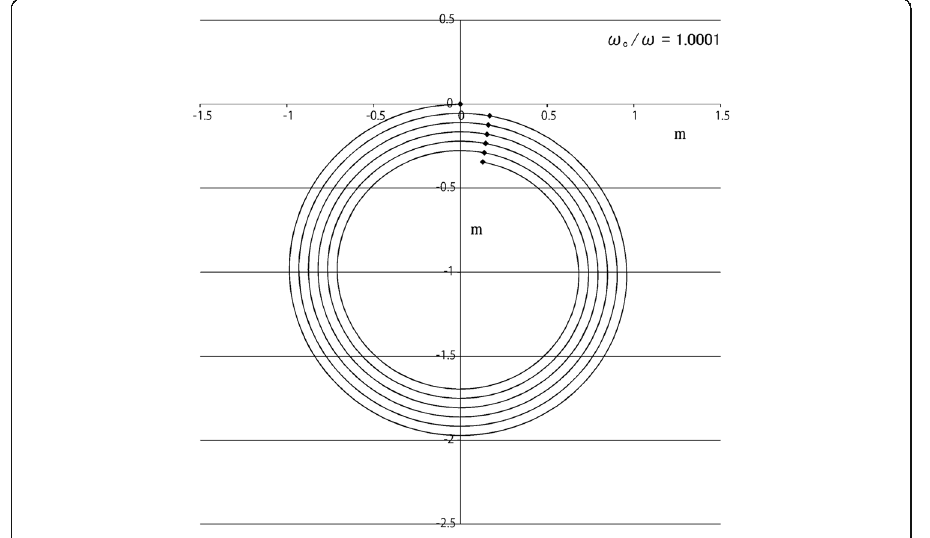
Fig. 6 The gyration orbit of a nonrelativistic electron. The conditions are the same with in Fig. 3, except for